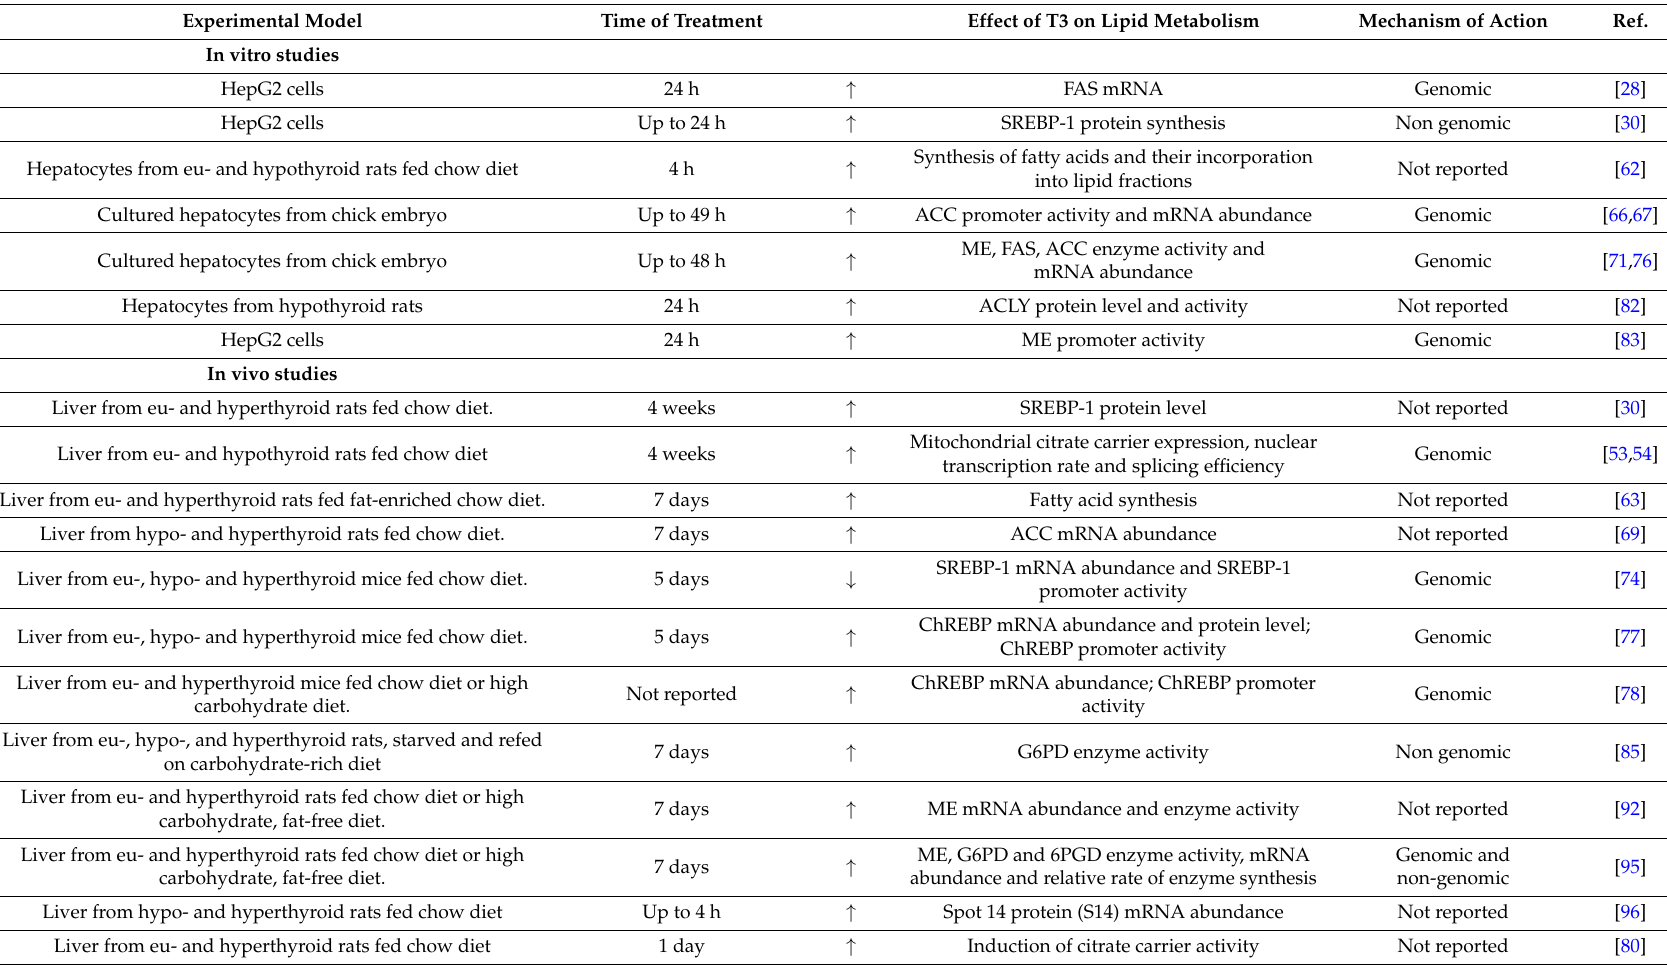
Table 1. Role and mechanism of action of T3 on activity or expression of enzymes and other proteins involved in fatty acid metabolism. Experimental